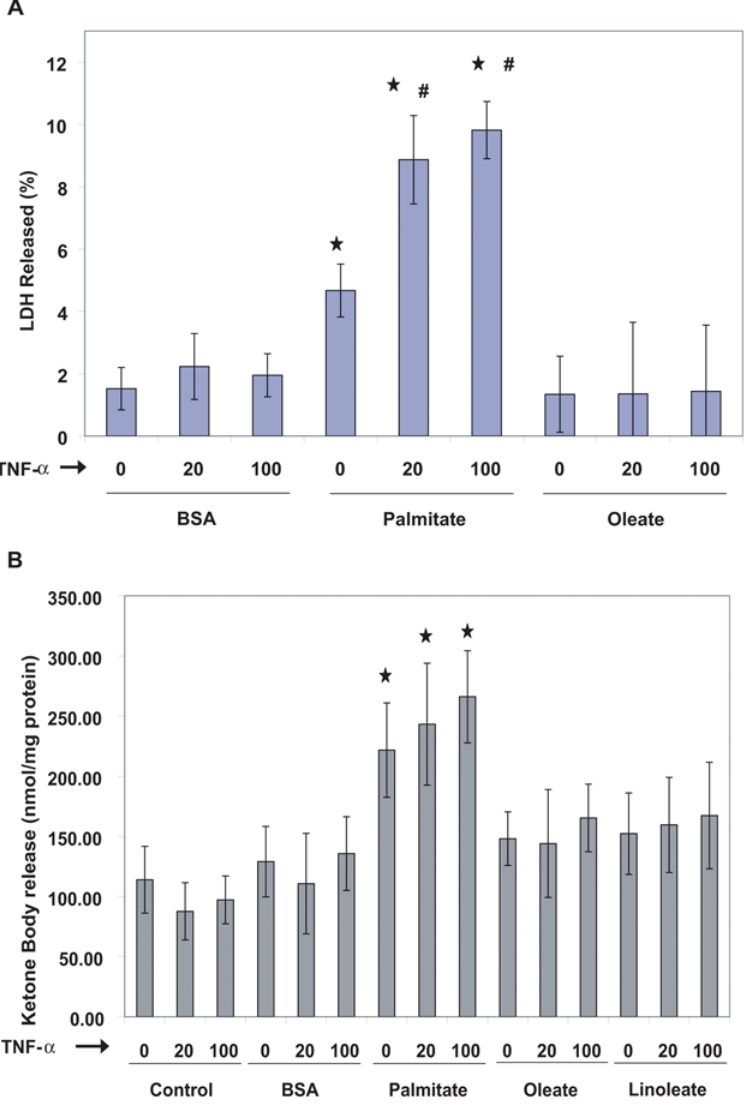
Figure 1. The cytotoxicity and ketone body production in response to various treatments. Confluent HepG2 cells were treated for 24 h with 0.7 mM of the indicated FFA complexed to 4% (w/v) BSA, in the presence or absence of TNF- a (0, 20 or 100 ng/ml). (A) Cytotoxicity of the treatments. The cytotoxicity was measured as the % LDH released, as defined in the methods section. (B) Ketone body production. Acetoacetate and beta-hydroxybutyrate release into the media were measured by enzymatic assays. Ketone body release was calculated as the sum of acetoacetate and beta-hydroxybutyrate release. Data presented as mean 6 s.d. of three independent experiments. w , significant FFA effect, p , 0.01, # , significant TNF- a effect, p , 0.01.